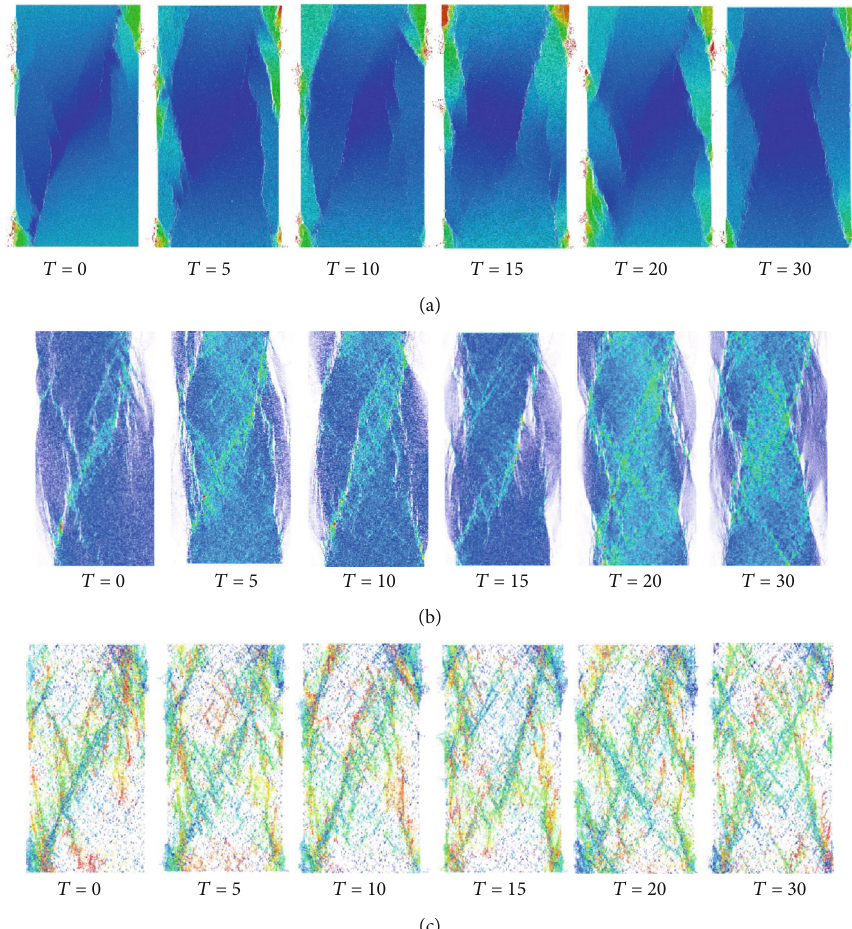
Figure 9: Distribution of sample particles “ displacement-force chain-crack ” under di ff erent salt damage erosion cycles. (a) Displacement distribution of sample particles under di ff erent salt erosion cycles. (b) Distribution of force chains of sample particles under di ff erent salt erosion cycles. (c) Distribution of sample particle cracks under di ff erent salt erosion cycles.